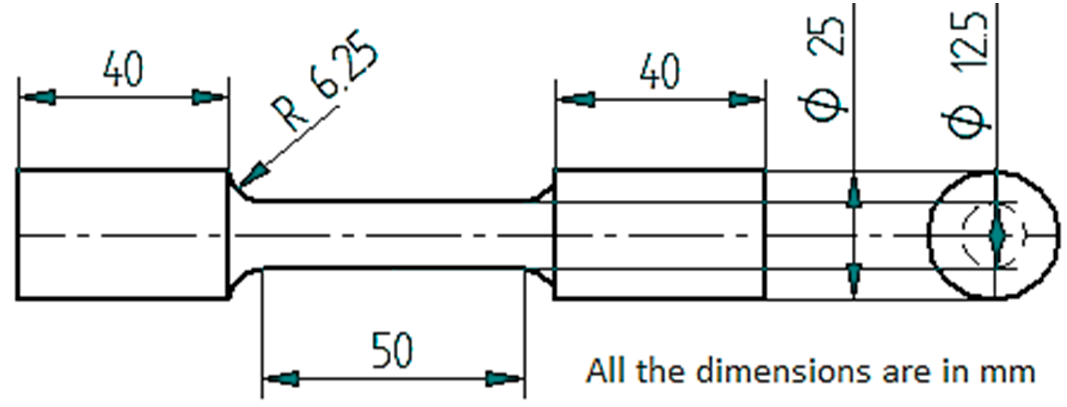
Figure 4. Tensile test specimen as per ASTM E8-95 standards.